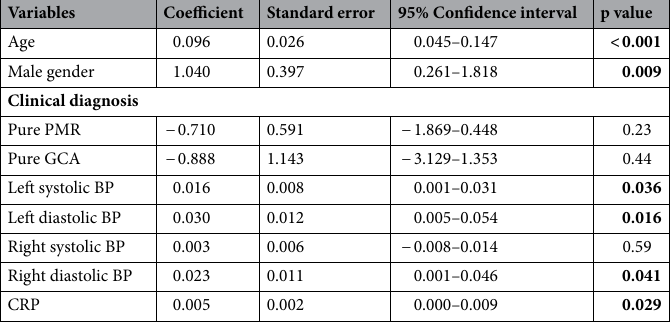
Table 3. Mixed model analysis considering PWV as the outcome variable. BP blood pressure, CRP C-reactive protein. p values marked in bold represent significant results.